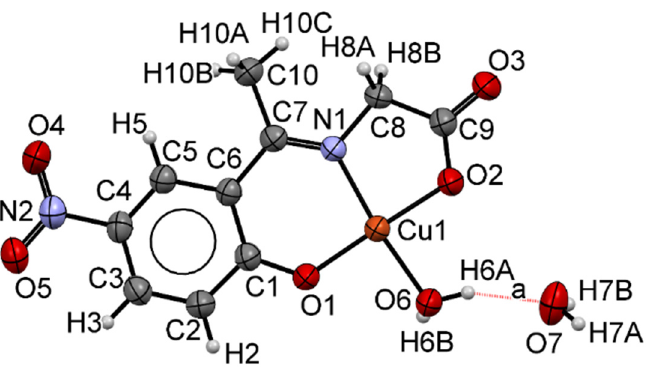
Figure 1. ORTEP drawing of complex 3 showing the atom numbering scheme and the thermal motion ellipsoids (50% probability level) for the non-hydrogen atoms. Table 1. Selected bond lengths (Å) and bond angles ( ◦ ) for 3 and 4